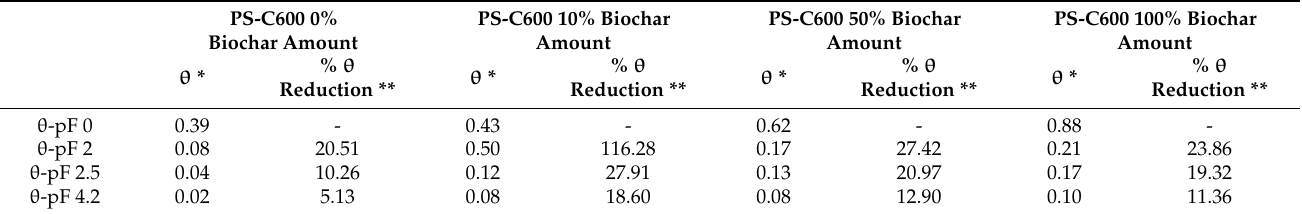
Figure 13. WHC for sand and biochar amounts of 0%, 10%, 50% and 100% in mixtures. In Table 6 the moisture contents for sand-biochar mixtures of 0, 10%, 50% and 100% are displayed, being notorious for the effect of biochar in the higher volumetric water amounts, for the same suction, retained in the mixtures silica-based sand with biochar. Table 6. Moisture soil contents for the mixtures sand-biochar at pF 0, 2, 2.5 and 4.